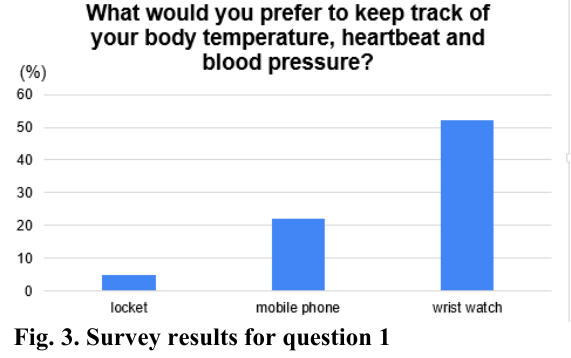
Fig. 3. Survey results for question 1